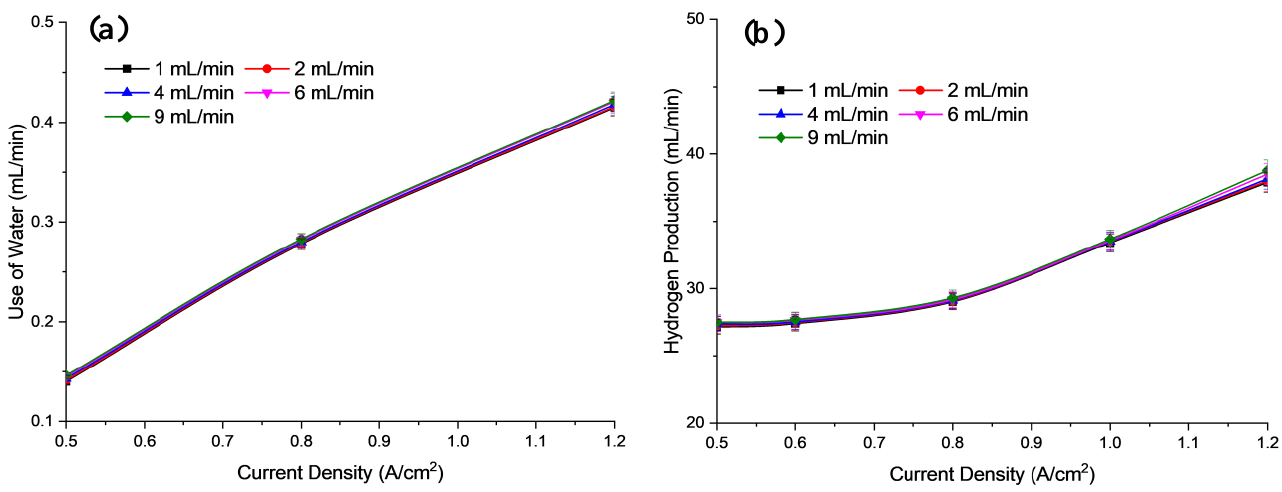
Figure 9. Profile of ( a ) use of water, ( b ) Hydrogen production based on electrolysis efficiency for different electrolyte flow rate at 30 °C operational temperature and concentration of electrolyte 2.0 M KOH.